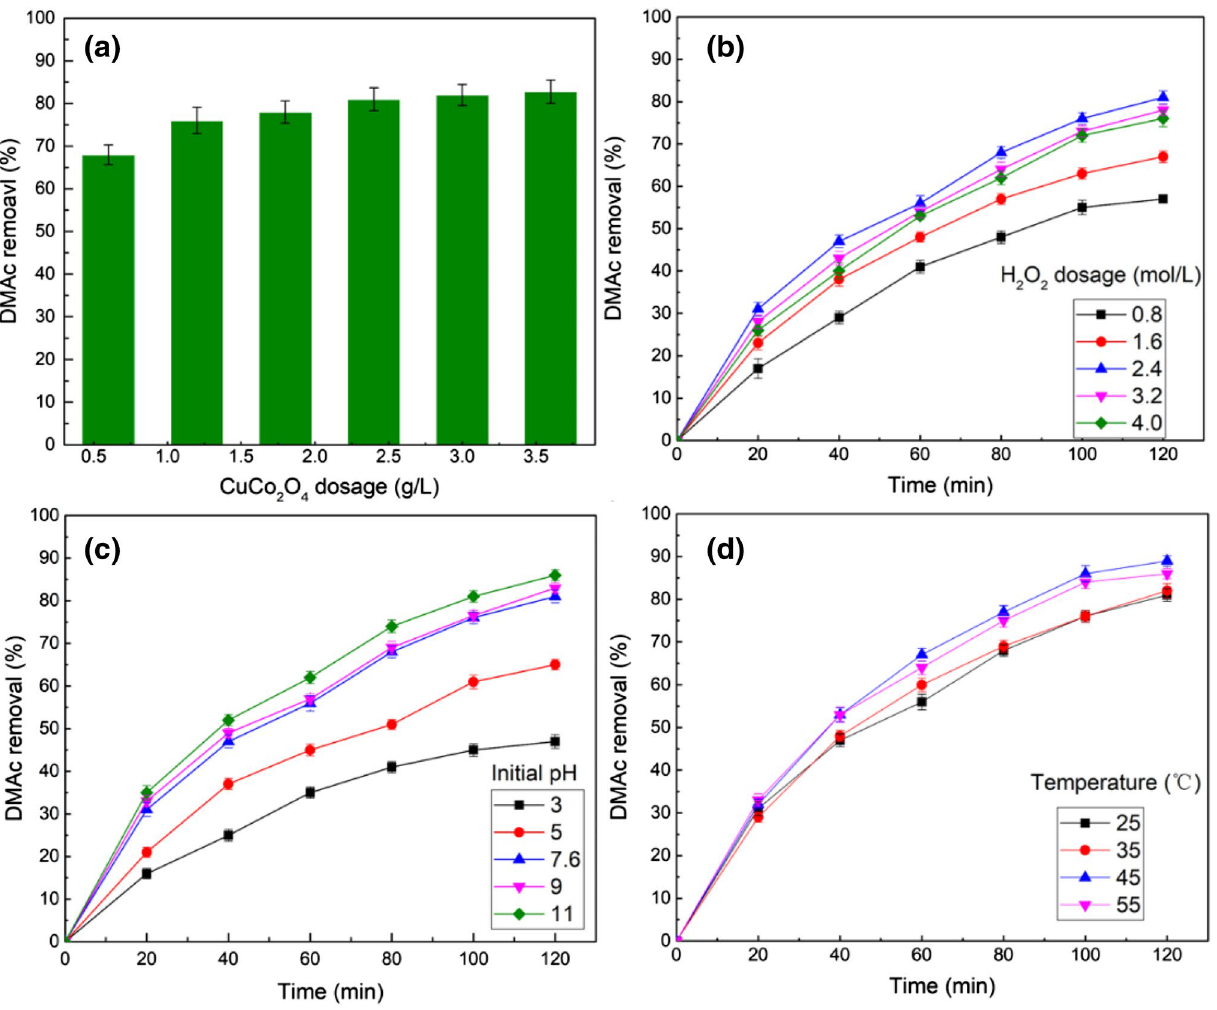
Fig. 7 Operational condition optimization of Fenton-like process for DMAc-contaminate wastewater treatment ([DMAc] alyst dosage, b H 2 O 2 dosage, c initial pH and d temperature